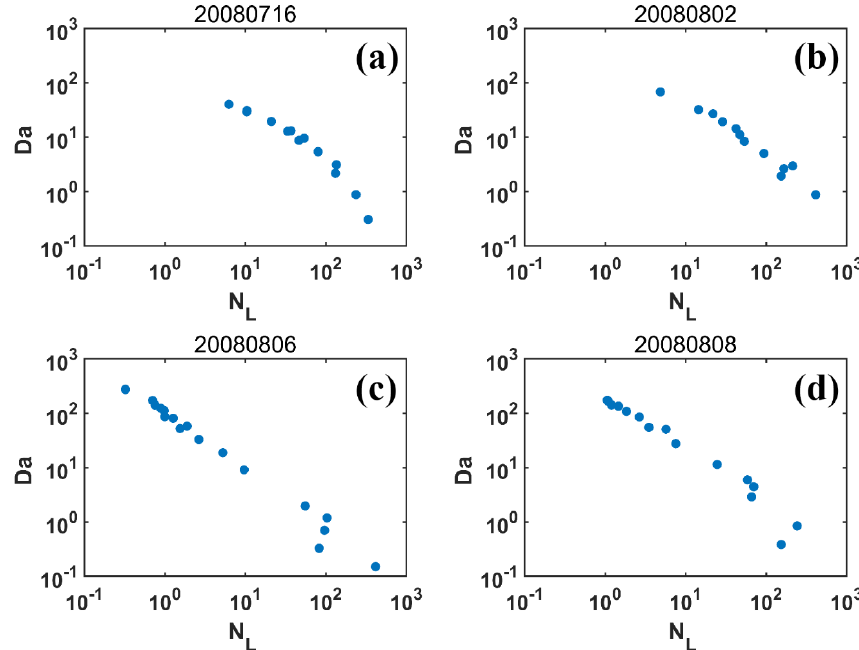
Figure 8. Relationships of Damköhler number ( Da ) vs. transition scale number ( N L ) on (a) 16 July 2008, (b) 2 August 2008, (c) 6 August 2008 and (d) 8 August 2008.